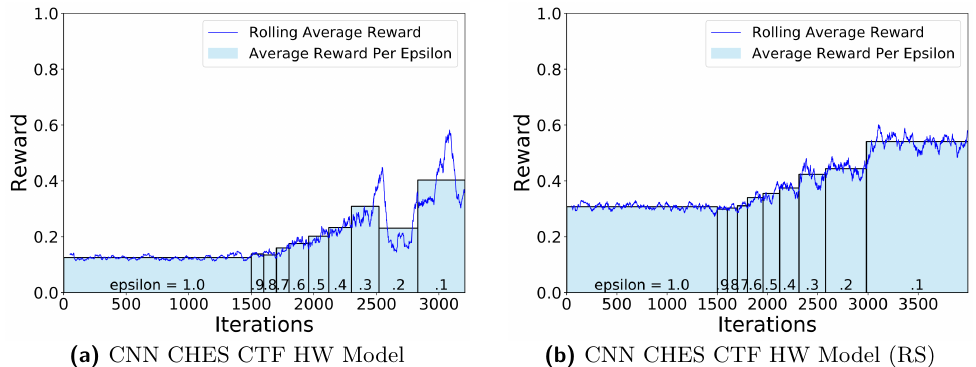
Figure 12: An overview of the Q-Learning performance for the CHES CTF dataset Experiments. The blue line indicates the rolling average of the Q-Learning reward for 50 iterations, where at each iteration, we generate and evaluate a neural network architecture. The bars in the graph indicate the average Q-Learning reward for all neural network architectures generated during that ε